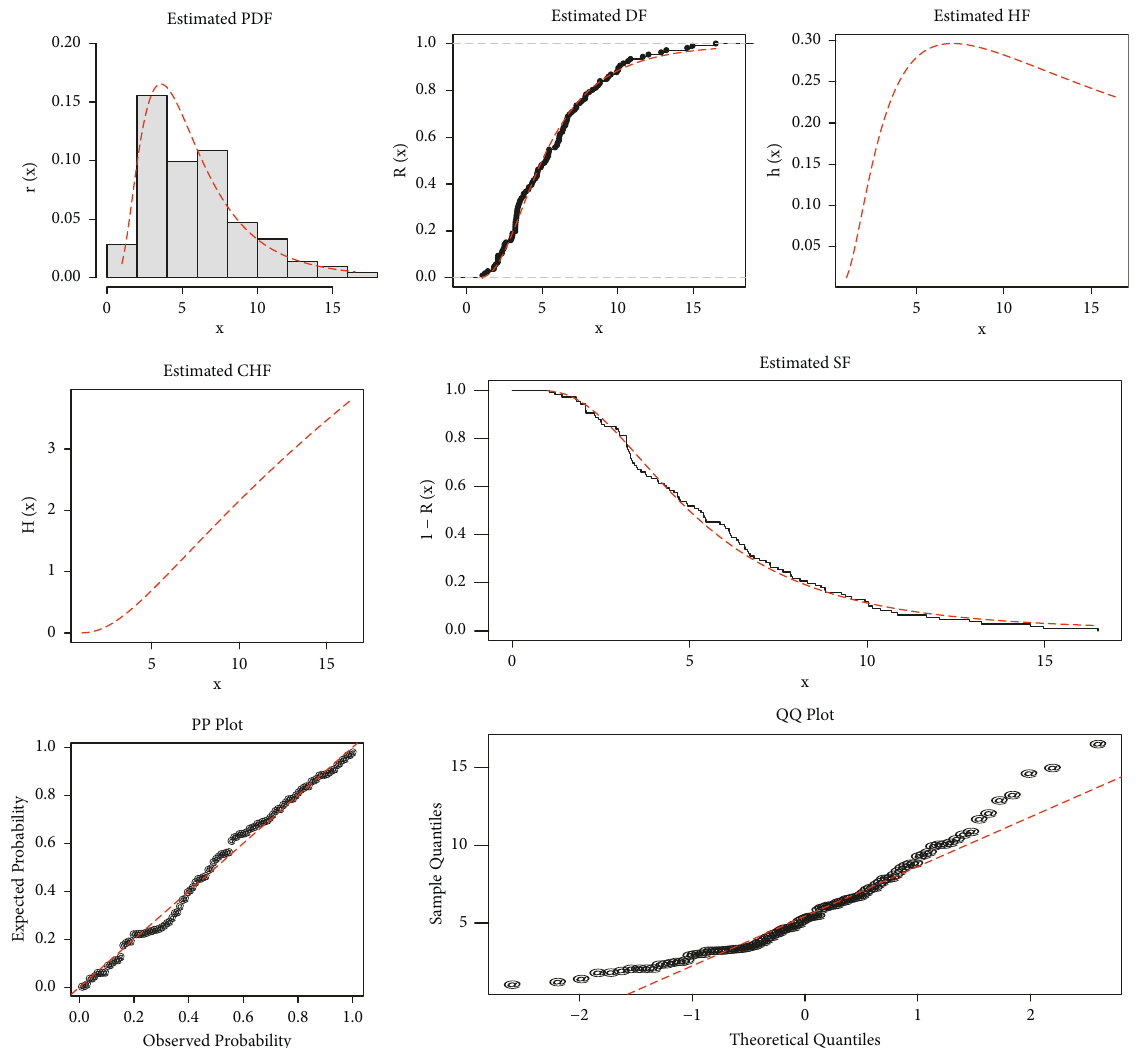
Figure 8: Visual illustration of the NG-IW distribution using the COVID-19 data